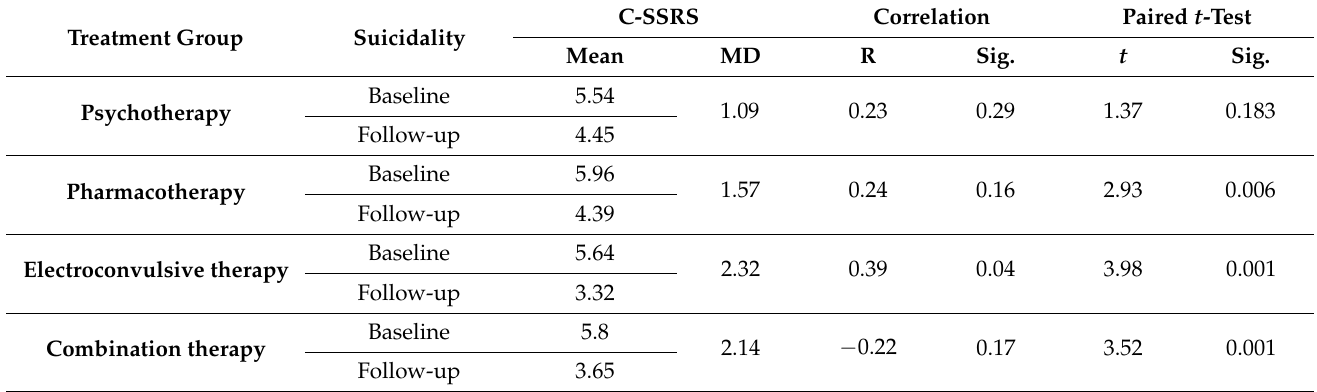
Table 2. Comparative assessment of treatment efficacy for different treatment modalities through the C-SSR Scale applied at baseline and after the 3-month follow-up.